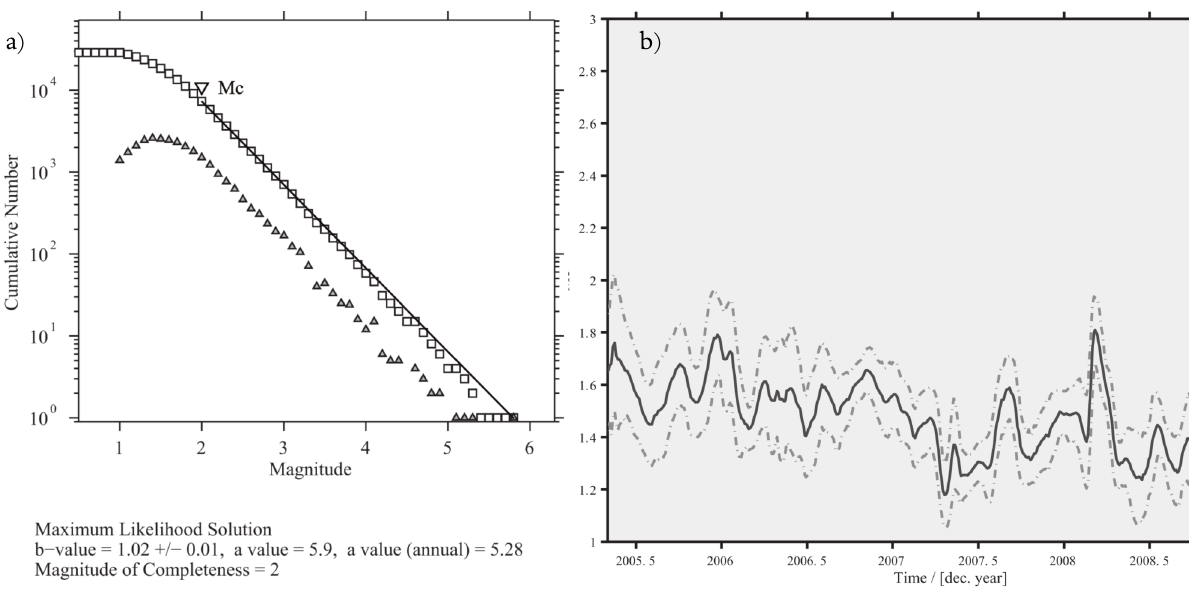
Figure 1. Completeness magnitude of the INGV bulletin (from April 16, 2005, to June 1, 2009) obtained by the maximum likelihood method. a) Frequency magnitude distribution for the whole dataset, giving M as a function of time. c) M as a function of b) M c c